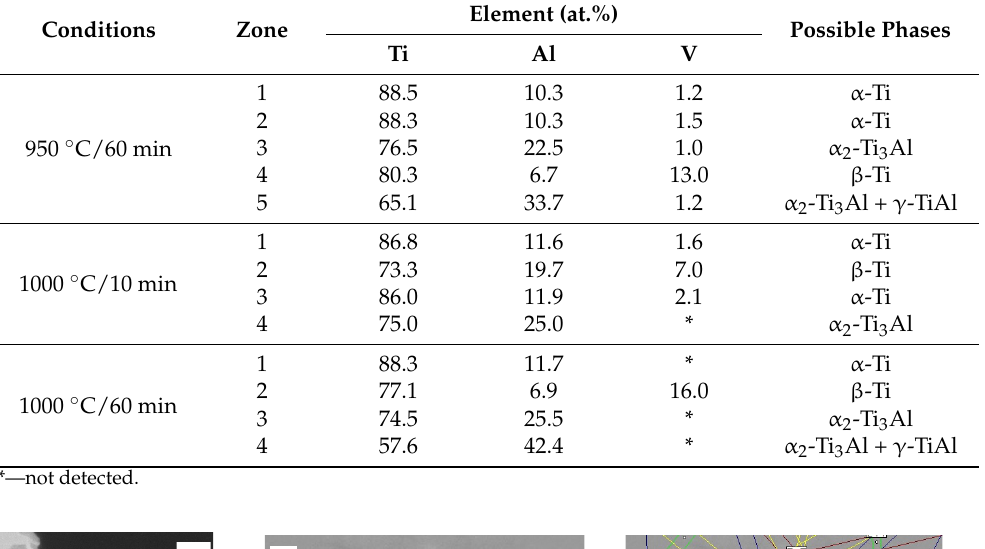
Table 1. Chemical composition obtained by EDS of the zones in Figure 6.